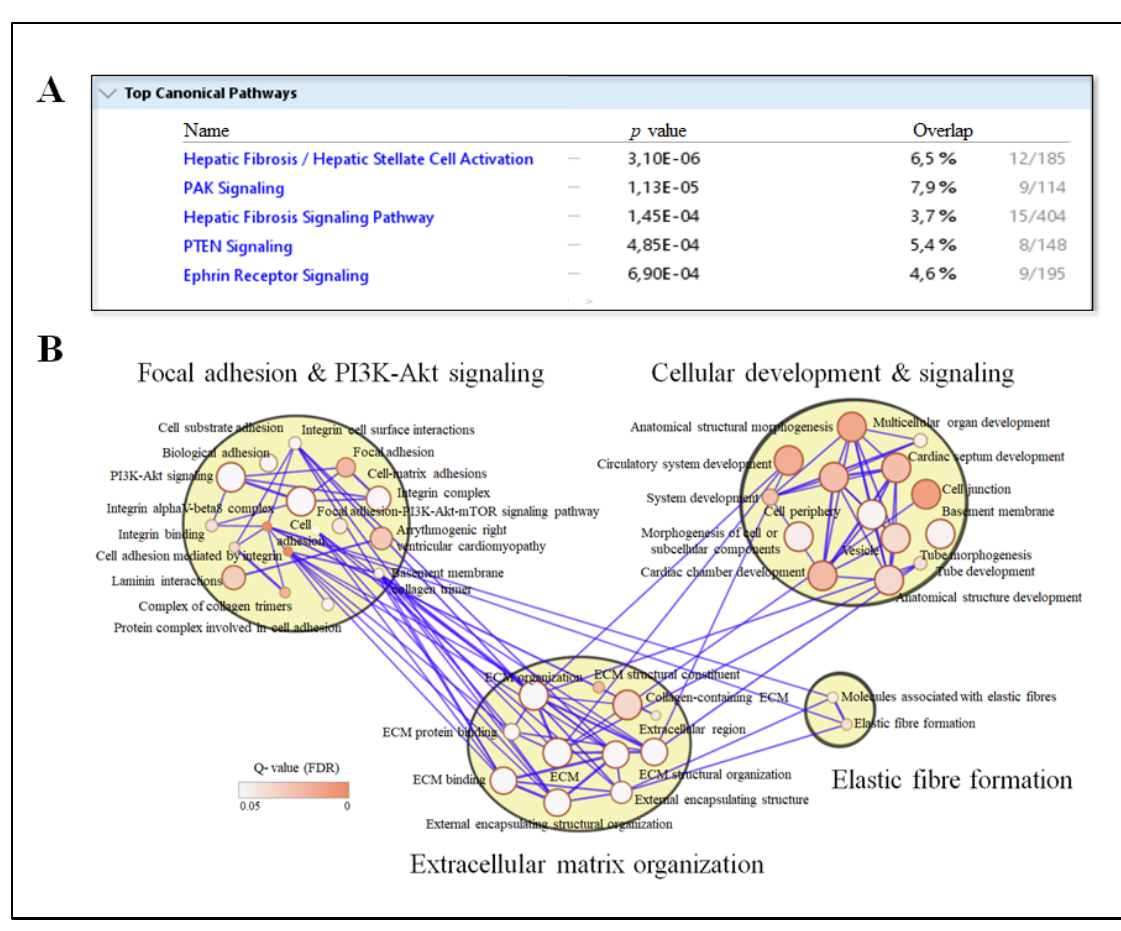
Figure 3. Enriched pathways corresponding to the significantly ( p value < 0.01) associated genes with serum IPA signal intensities. ( A ) Top canonical pathways based on a total of 278 transcripts IDs and corresponding genes that were nominally associated with IPA (Ingenuity Pathway Analysis). The p value for the enrichment for each pathway is shown with the total overlapping genes percentage. ( B ) Enrichment map based on gene ontology and reactome terms (g:Profiler in Cytoscape). The connection between the nodes (edges) are depicted with blue lines and intensity of red color indicates the Q value (adjusted p value) for the enrichment score for each node.